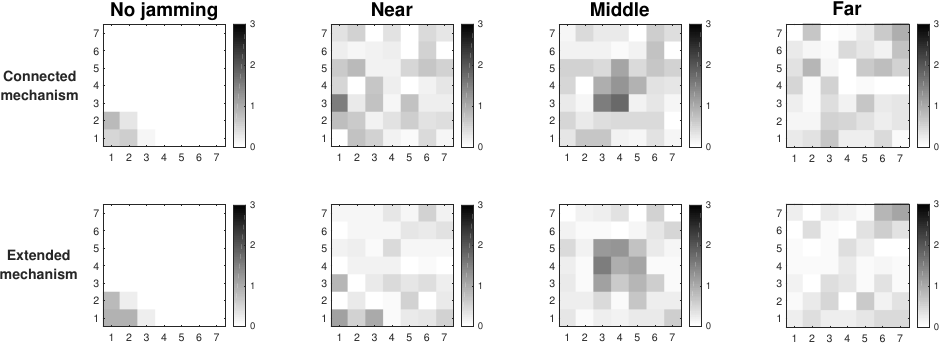
Figure 5. Connected vs extended mode under high traffic.